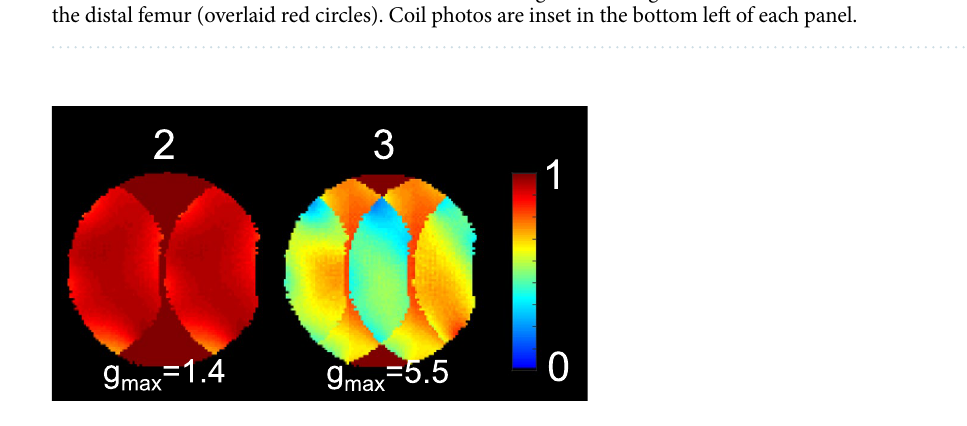
Figure 12. Inverse geometry factor (1/g) maps for twofold and threefold acceleration in the left–right direction in the axial imaging plane. Text overlays indicate the maximum geometry factors (g max